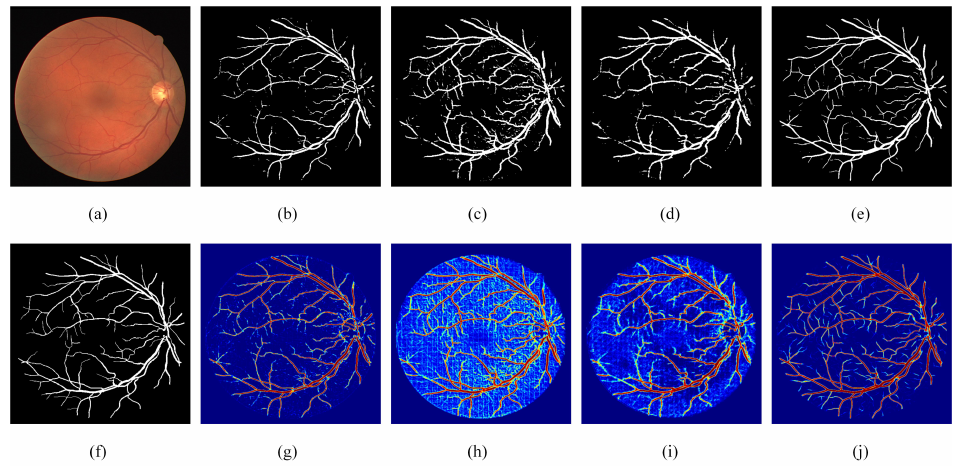
Figure 5. Visual examples of ablation experiments. ( a ) Fundus image; ( b ) Segmentation result of RC-Net; ( c ) Segmentation result of RRC-Net; ( d ) Segmentation result of DE-Net; ( e ) Segmentation result of DEF-Net; ( f ) Ground truth of the fundus image; ( g ) Heatmap of RC-Net; ( h ) Heatmap of RRC-Net; ( i ) Heatmap of DE-Net; ( j ) Heatmap of